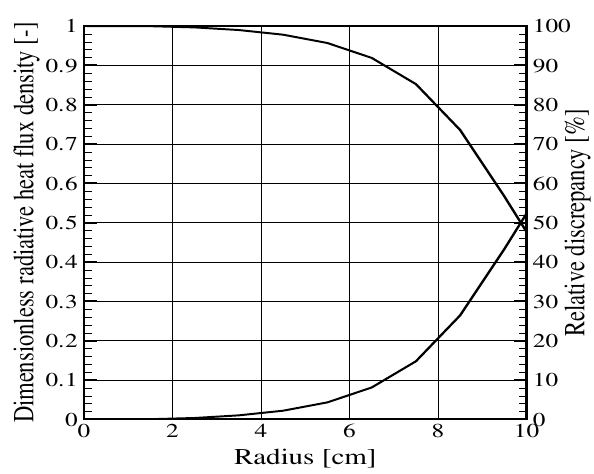
Figure 7. Numerical evaluation of an incident flux received under a cone, at a distance of 2.5 cm below the cone. Normalized flux density (left-hand scale) and relative discrepancy with the maximum value (right-hand scale) as a function of the radial distance from the cone axis.